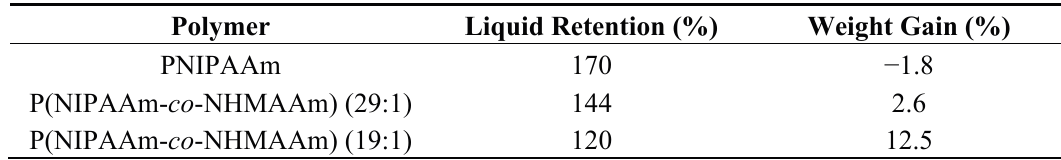
Table 3. Weight gain rates of cotton